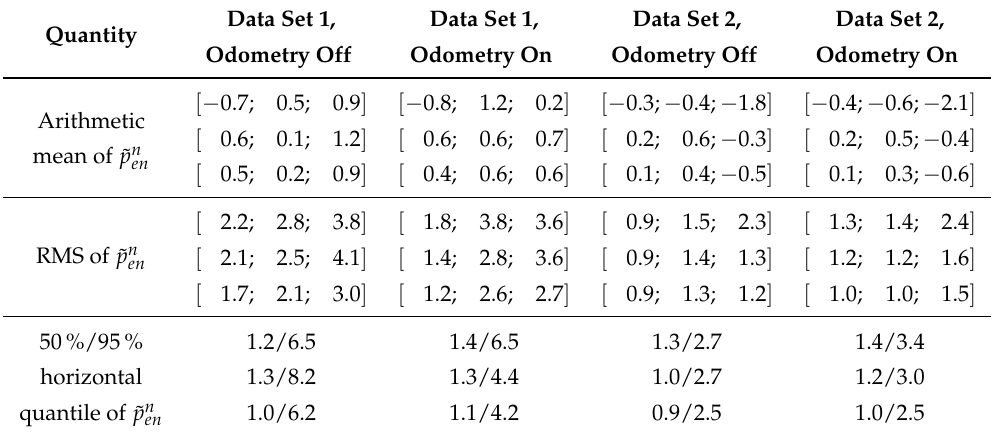
Table 8. Accuracy Metrics for Position Error, with and Without Odometry Aiding. GPS L1 Algorithm (First Line of Each Cell), Multi-Frequency GPS Algorithm (Second Line of Each Cell) and Multi-Frequency/Multi-Constellation Algorithm (Third Line of Each Cell). ENU Coordinate Frame, all Values in m.